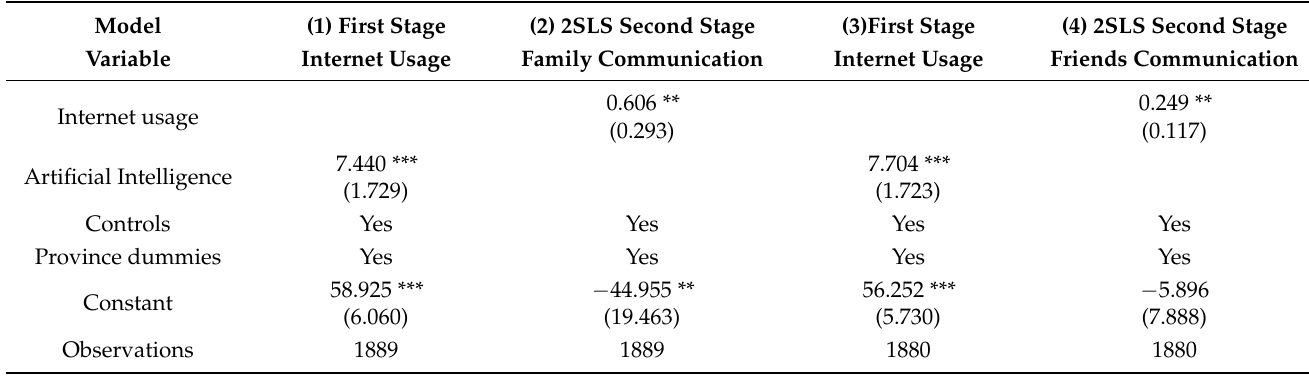
Table 5. Endogeneity tests: impacts on communications using an instrumental